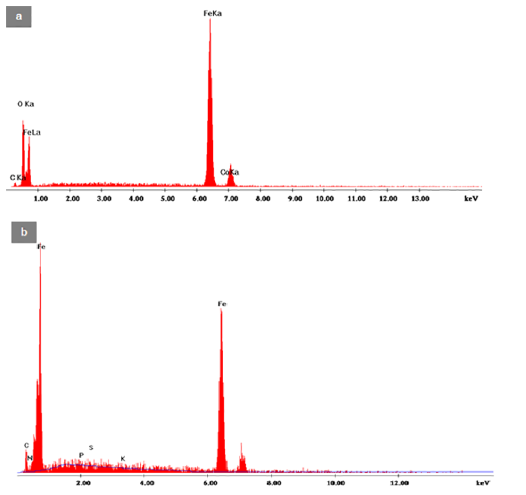
Figure 11. EDS spectra of the surface of CS-ASTM 1020 in the absence of inhibitor (a) and in the presence of 1.112 g L -1 of cocoa bark extract after 90 min immersion in 18.23 g.L -1 HCl